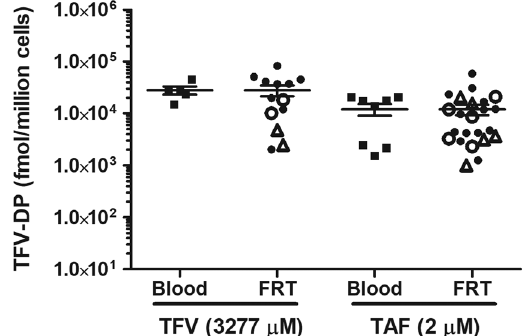
Figure 1. Intracellular TFV-DP concentrations from TFV/TAF treatment in CD4 + T cells from blood and female reproductive tract tissues. TFV-DP concentrations were measured by LC-MS/MS in purified CD4 + T cells from blood (n = 11) and from FRT (Endometrium: n = 17, Cervix: n = 5, Ectocervix: n = 5) treated with TFV (3277 µ M) or TAF (2 µ M) for 24hr. Values are expressed as fmol/million cells. Each symbol represents blood CD4 + T cells from different female donors or FRT CD4 + T cells from an individual patient. Dark squares indicate blood CD4 + T cells. Dark circles indicate endometrial CD4 + T cells. Open circles indicate cervix CD4 + T cells and triangles indicate ectocervix CD4 + T cells. The mean and SEM are